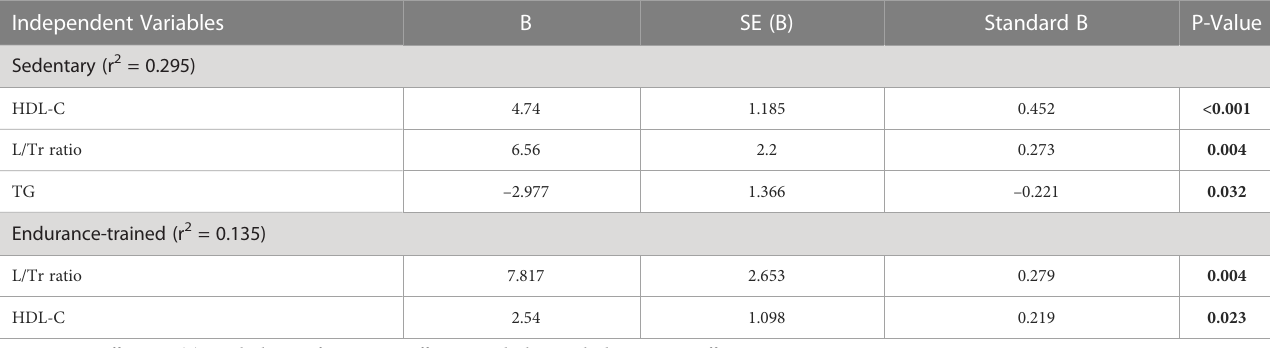
TABLE 4 Multiple-regression analysis for adiponectin as a dependent variable. Independent